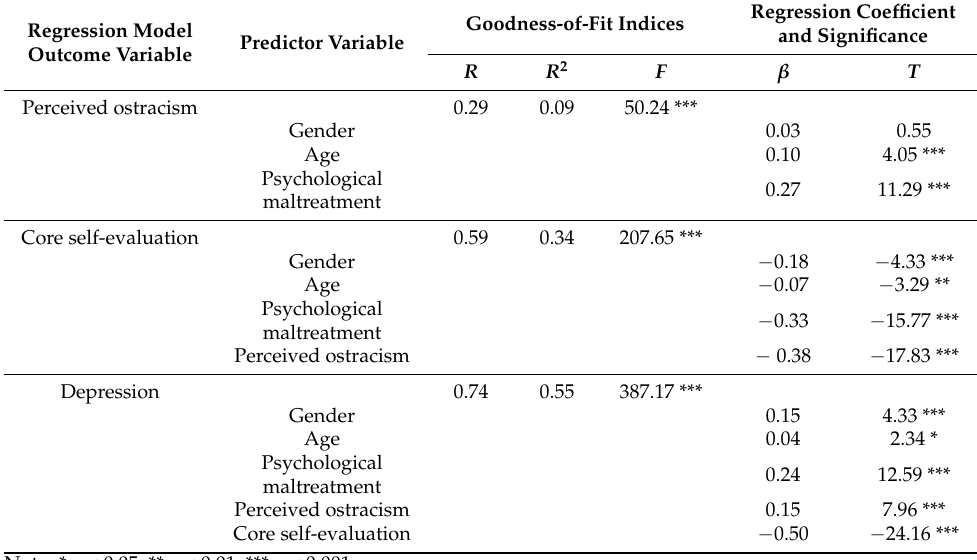
Figure 2. Standardized regression coefficients showed that psychological maltreatment was positively related to perceived ostracism ( β = 0.27, p < 0.001), which, in turn, was positively related to depression ( β = 0.15, p < 0.001). Moreover, psychological maltreatment negatively predicted core self-evaluation ( β = − 0.33, p < 0.001), and core self-evaluation, in turn, was a negative predictor of depression ( β = − 0.50, p < 0.001). In addition, perceived ostracism was negatively related to core self-evaluation ( β = − 0.38, p < 0.001). Table 2. Results of the multiple mediation analysis.